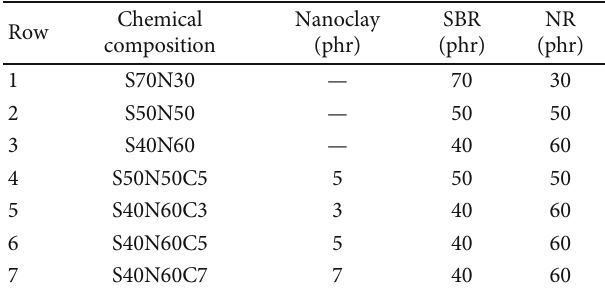
Table 1: Types of samples used in fatigue testing.